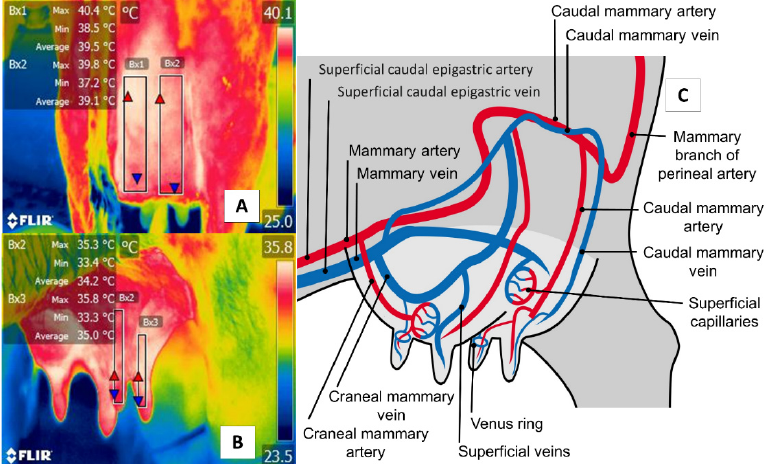
Figure 6. Thermal window of the udder region ( regio uberis ), including the mammary gland, in dairy bovines ( Bos ) and river buffaloes ( Bubalus bubalis ). ( A ) Dairy bovine (Holstein Bos Indicus , in production) are represented in the Figure with a square (Bx1) that extends proximally from the abdominal insertion of the mammary cistern and distally to the insertion of the teat, without considering the temperature of the latter. ( B ) River buffalo. The window is traced from the distal region of the teat to the cistern of the mammary gland. For this species, the full teat is considered, unlike in dairy bovines. Although significant anatomical differences exist between these two species, microcirculatory changes from the mammary arteries and veins can be obtained, as shown in ( C ). The justification for using this window in IRT is based on the fact that mastitis is characterized by bacterial colonization in the mammary gland generates a local inflammatory process due to the presence of proinflammatory cells that produce a secretion of prostaglandin, histamine, serotonin, and interleukins, which, in turn, trigger vasodilatation of the mammary capillaries, increasing the temperature of the region by 1.5 ◦ C. This inflammatory increase could correlate with the rise of somatic cells